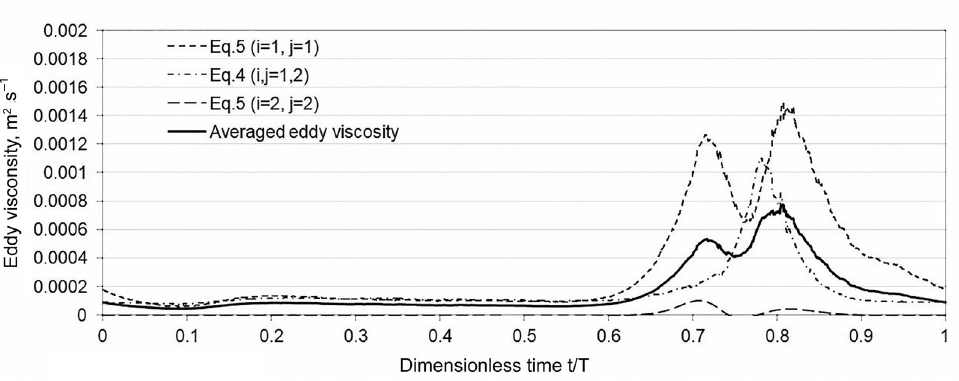
Fig. 5. Eddy viscosity based on theoretical equations with the surface direction index i and the flow direction index j . The averaged eddy viscosity values, derived from the results of Eq. (4) and Eq. (5), are shown as a continuous curve.